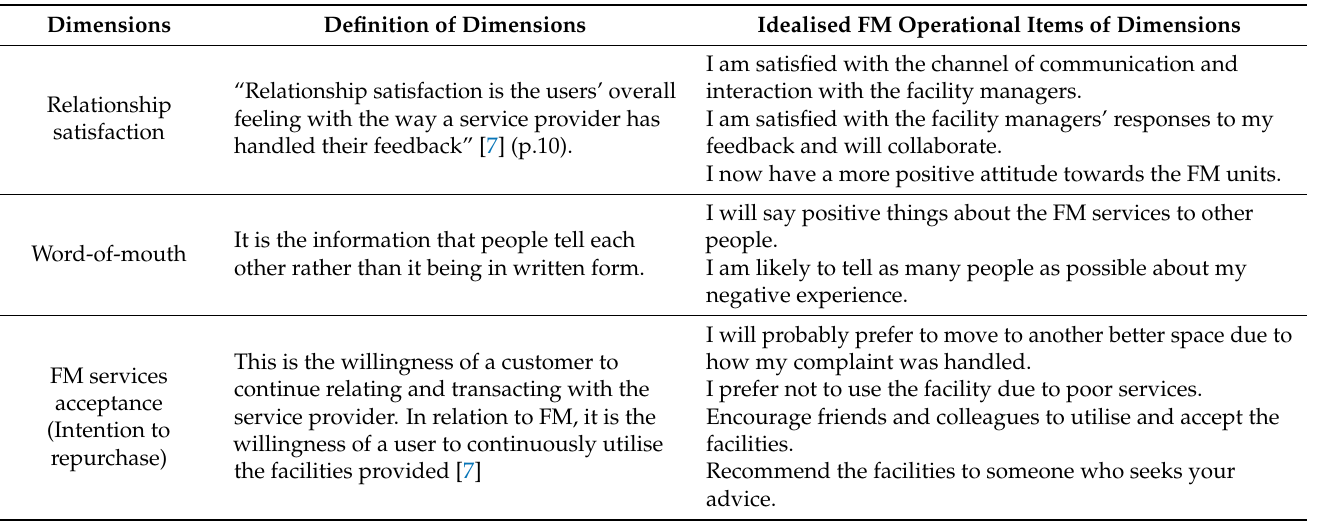
Table 2. Core user post-feedback behaviour